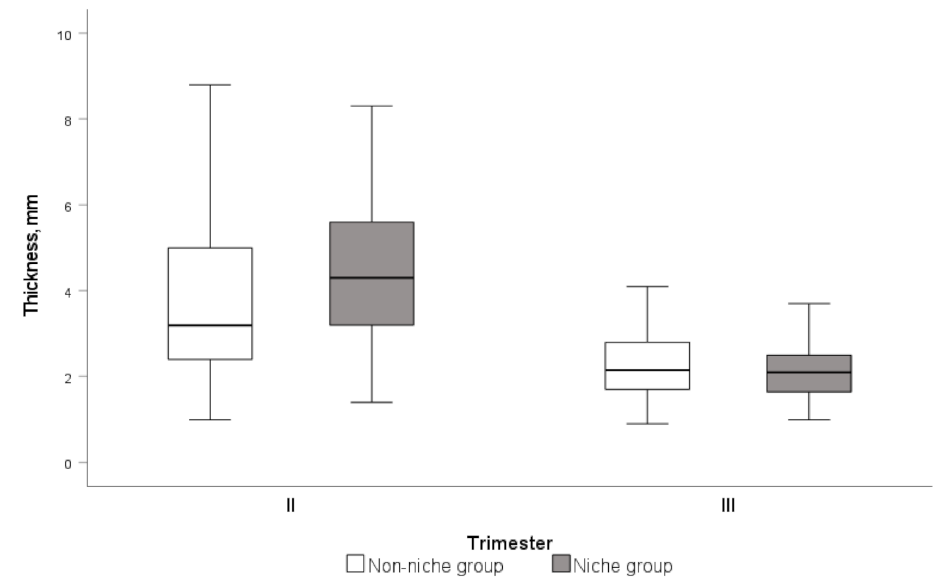
Figure 5. Median myometrial LUS thickness at the second and third trimester of pregnancy in the niche group and non-niche group. Data are presented as median (IQR).